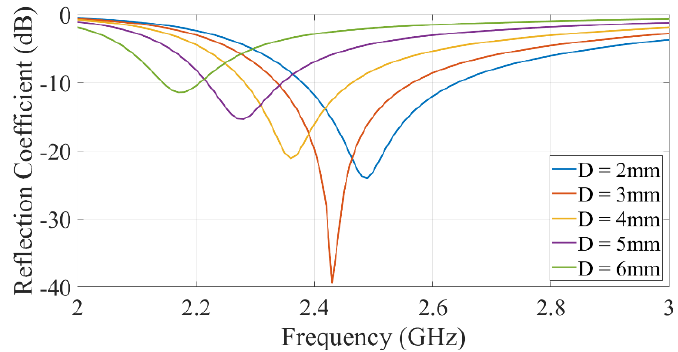
Figure 3. Simulated reflection coefficient of the proposed PIFA design for different slot depths.